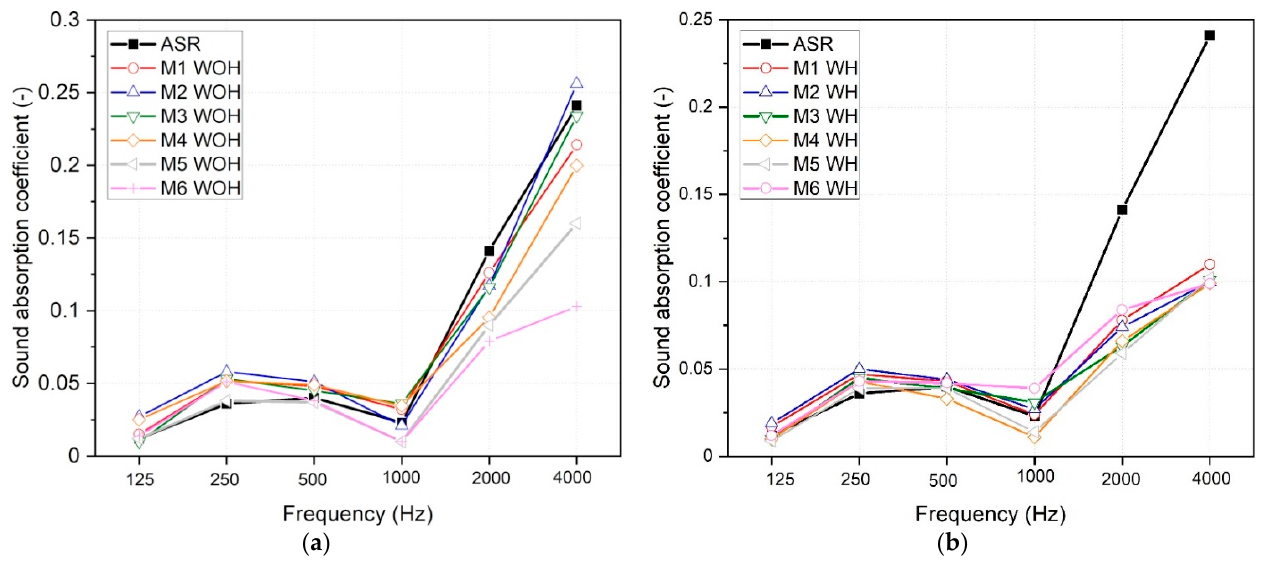
Figure 11. Sound absorption coefficients of ASR-based compositions prepared without ( a ) and with ( b ) homogenization.